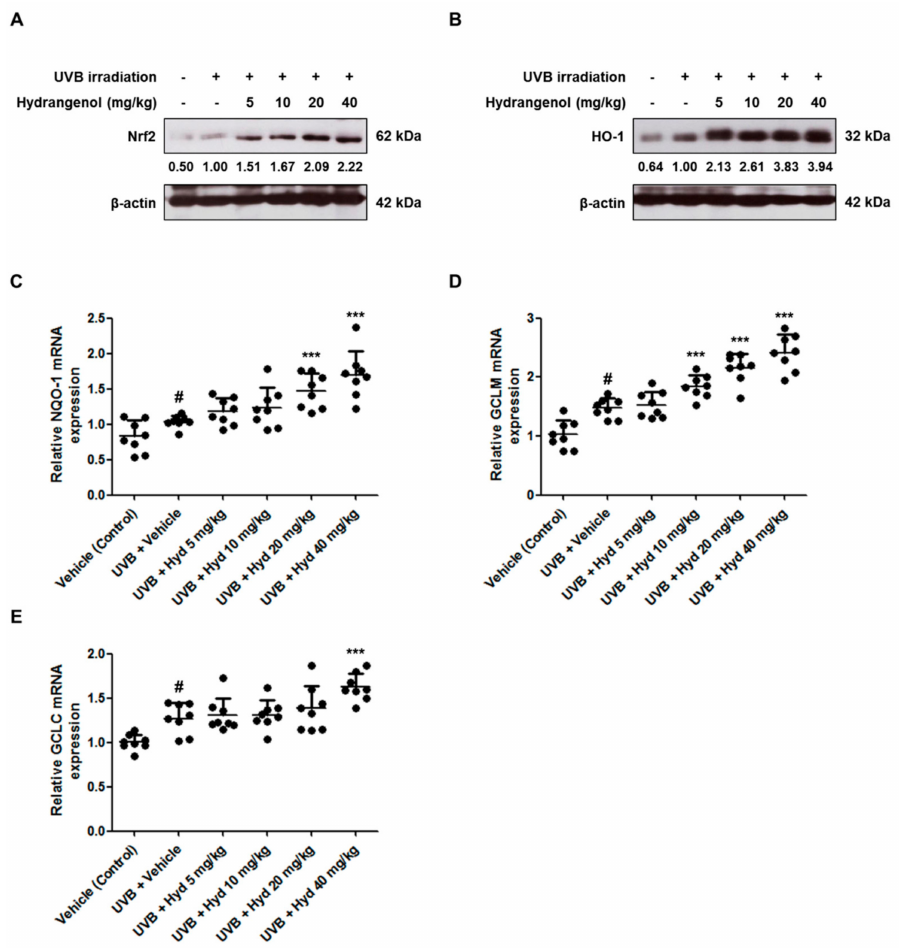
Figure 8. E ff ects of oral administration of hydrangenol on the Nrf2 / ARE signaling pathway in UVB-irradiated hairless mice. HR-1 hairless mice were administered hydrangenol (5, 10, 20, or 40 mg / kg) daily for 7 weeks of exposure to UVB. Total proteins were extracted from dorsal skin tissues. ( A , B ) The expression of target proteins was estimated using Western blotting using specific Nrf2 and HO-1 antibodies. The internal control was a β -actin protein. Representative blots of ( A ) Nrf2 and ( B ) HO-1 expression. Each band is representative of three experiments. ( C – E ) The mRNA levels of NQO-1, GCLM, and GCLC were analyzed by qRT-PCR. Values are expressed as means ± SD ( n = 8). # p < 0.05 vs. the vehicle-treated control group; *** p < 0.001 as compared to the UVB